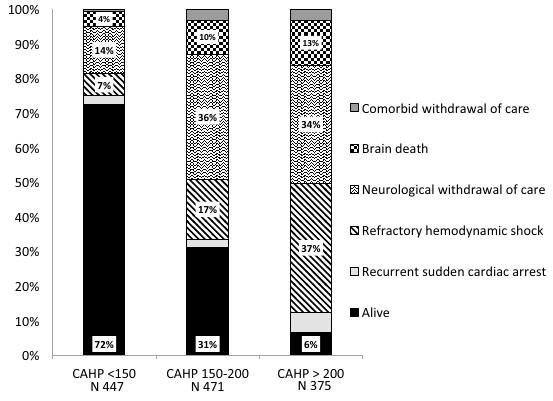
Fig. 1 NSE values and NSE cutoff values at 24, 48, 72 h after ROSC for outcome prediction according to CPC at 6